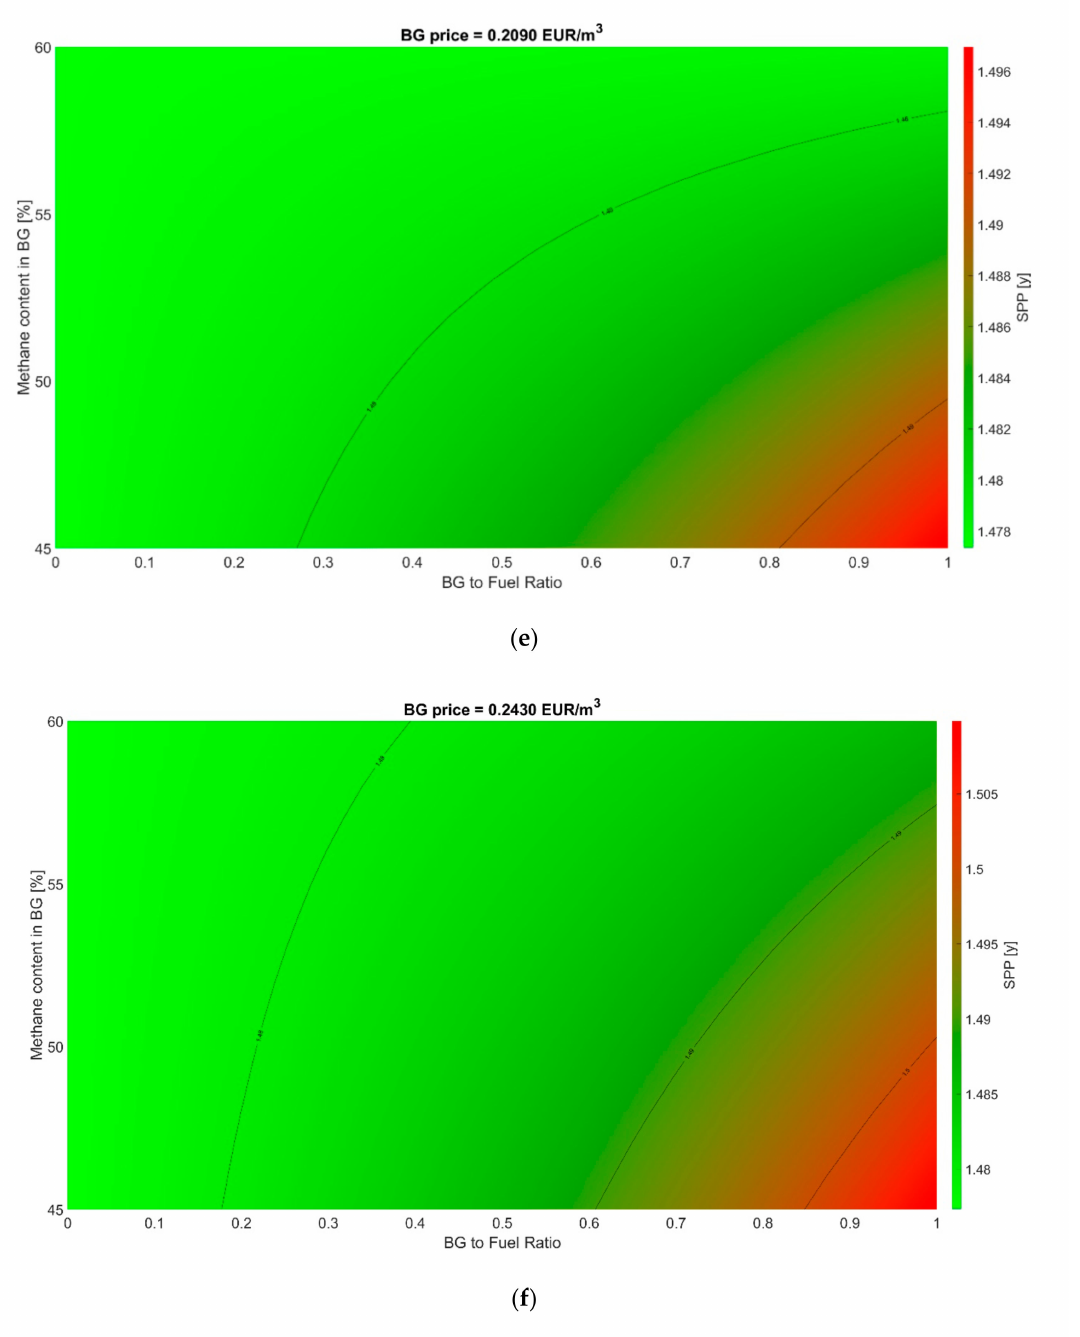
Figure 11. SPP for scenario B of milk drying unit as a function of biogas-to-fuel ratio, methane content in biogas, and biogas price—0.073 EUR / m 3 ( a ), 0.107 EUR / m 3 ( b ), 0.141 EUR / m 3 ( c ), 0.175 EUR / m 3 ( d ), 0.209 EUR / m 3 ( e ), and 0.243 EUR / m 3 ( f